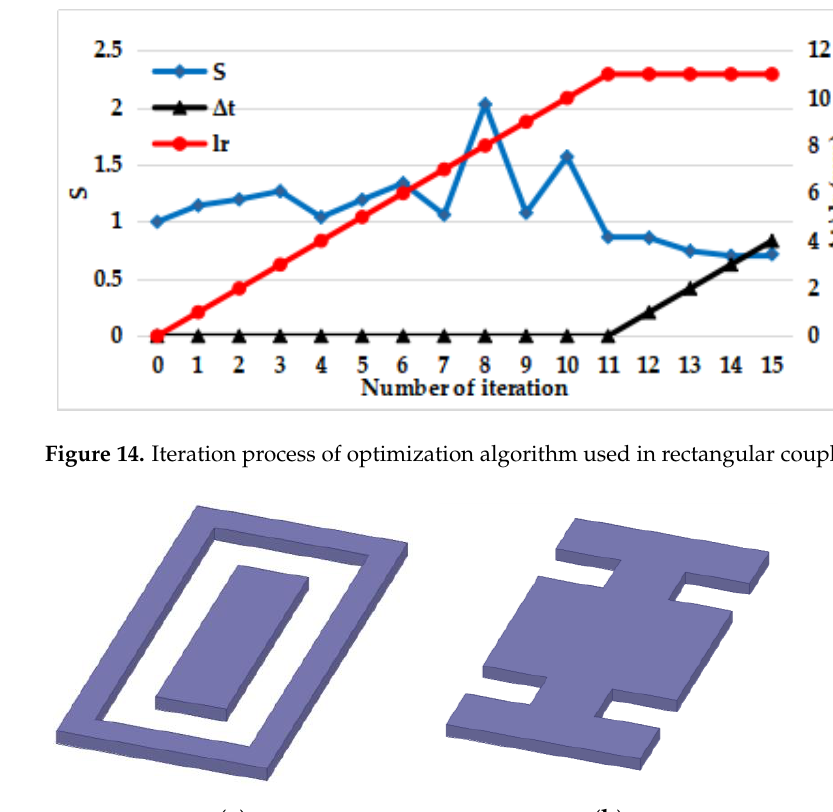
Figure 15. Optimized core in square coupler: ( a ) Primary core; ( b ) Secondary core.